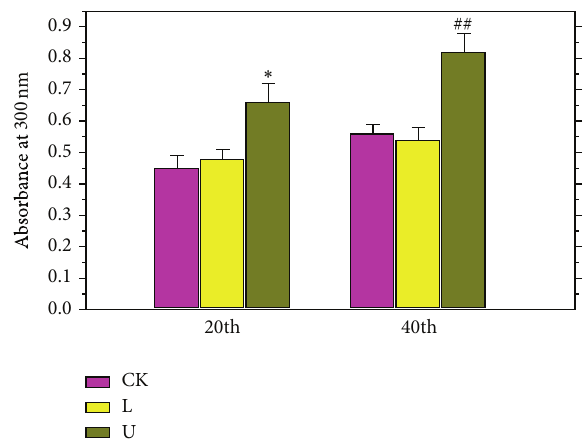
Figure 2: Effects of red LED and UV-B on the UV-B absorbing compoundsofthemungbean.CKinthefigurereferstouseordinary fluorescent light as treat light sources. L in Figure refers to the use of both ordinary fluorescent light and red LEDs. U in the figure refers to using both ordinary fluorescent light and UV-B radiation light. Data are means and SE of six replicate plants. Error bars represent standard errors. Means with different letters above bars were significantly different at the 𝑃 < 0.05 level ( 𝑛 = 6 ) according to Duncan’s multiple range test ( ∗ 𝑃 < 0.05 ; ## 𝑃 < 0.01